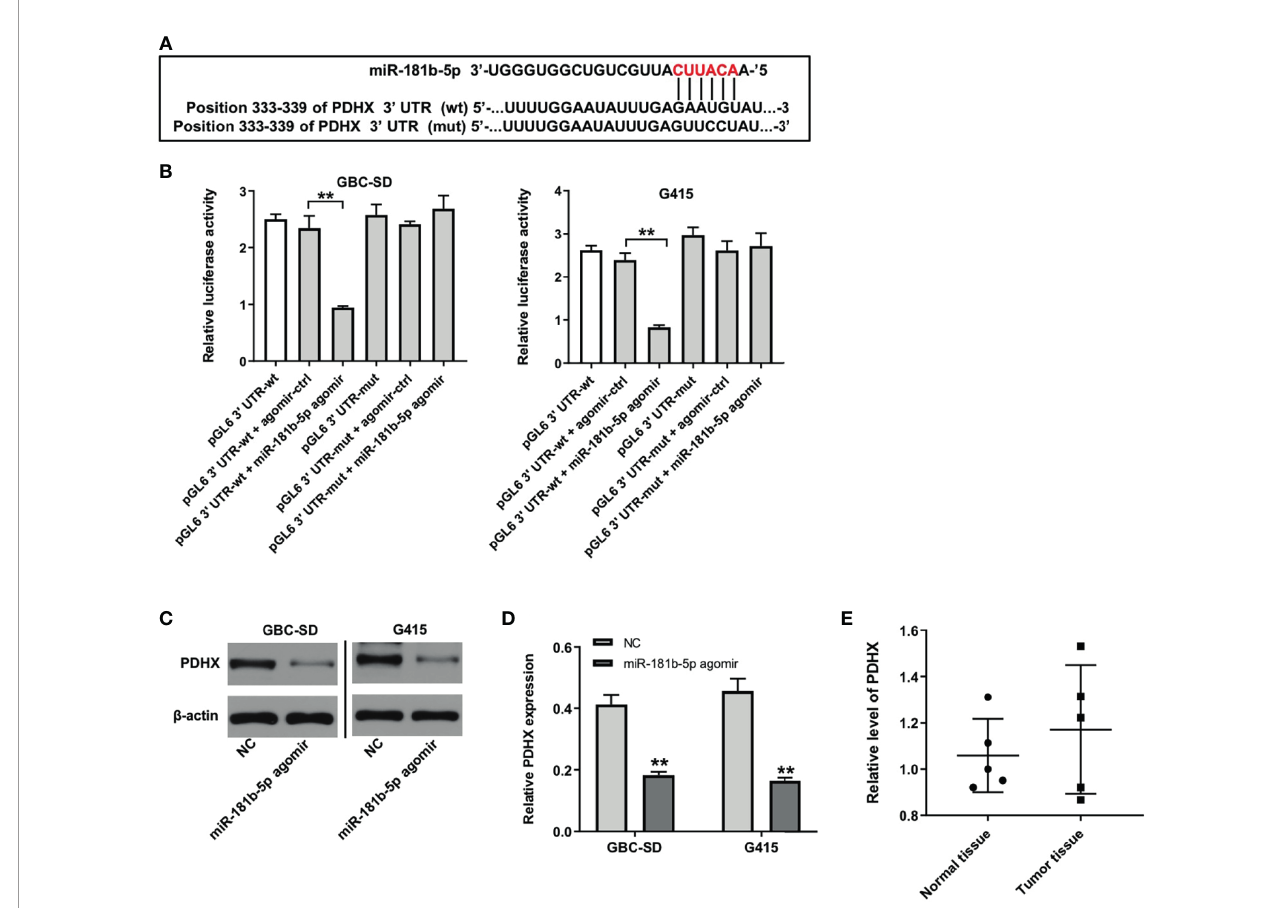
FIGURE 5 | PDHX is a direct target of miR-181b-5p. (A) Sequence alignment of miR-181b-5p with the binding sites within the wt or mut regions of PDHX. (B) Dual-luciferase reporter assay was used to verify the relationship between miR-181b-5p and PDHX. (C, D) Western blotting was used to determine the level of PDHX. (E) RT-qPCR was performed to measure the level of PDHX in fi ve non-neoplastic gallbladder tissues (normal tissues) and fi ve gallbladder tumor tissues (tumor tissues). **P < 0.01 compared with control group, n =